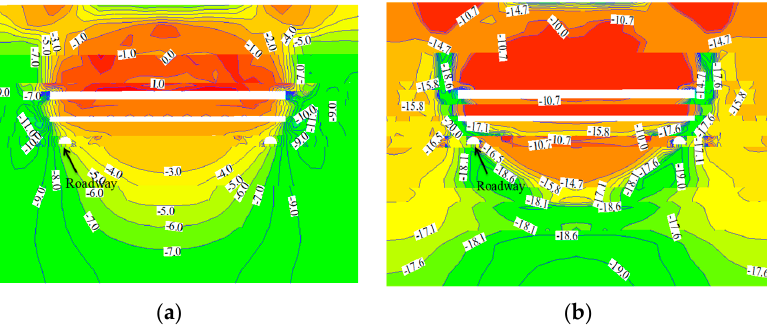
Figure 15. Stress distribution characteristics of the floor after coal seam 16# mining: ( a ) Minimum principal stress (MPa); ( b ) Minimum principal stress (MPa).